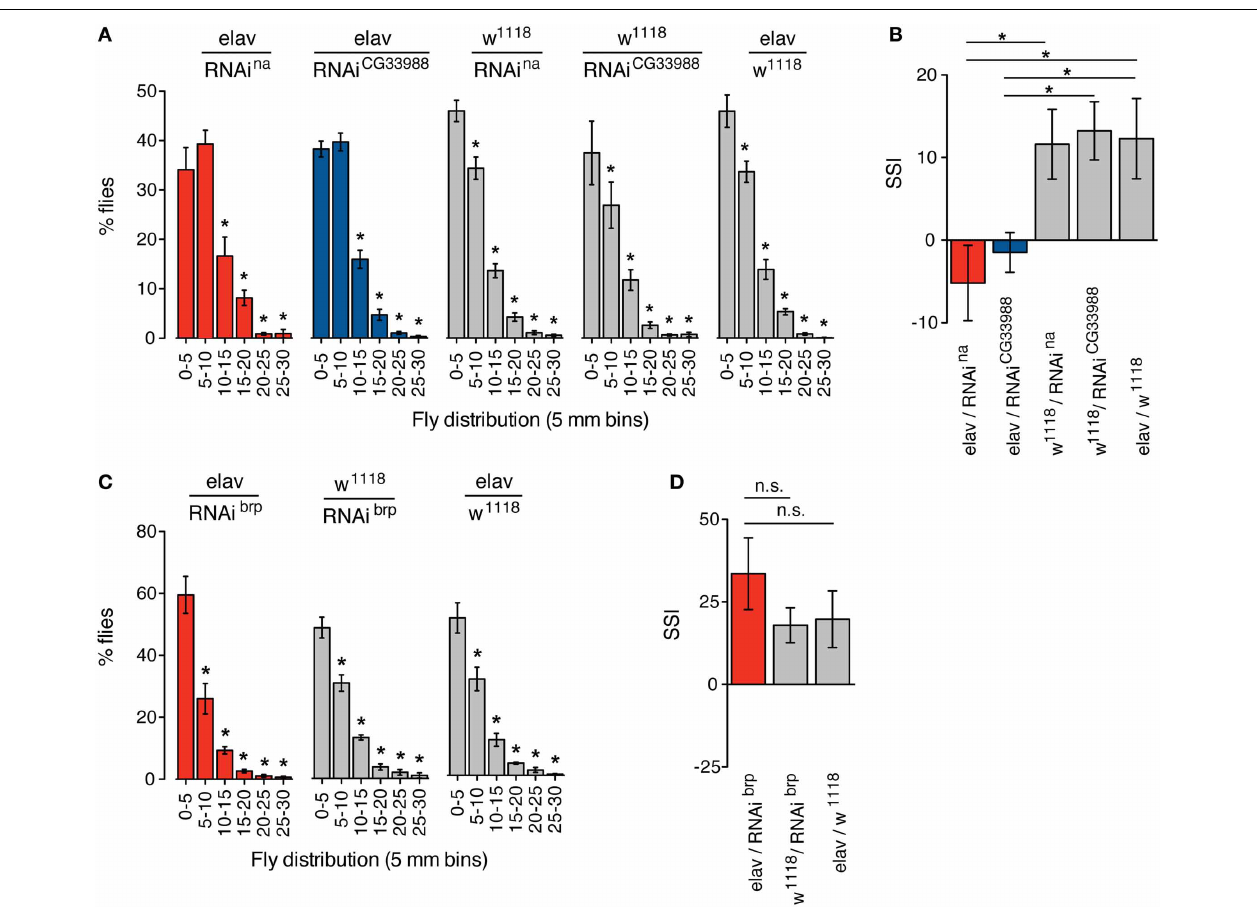
Index (SSI) calculated for the same groups of flies. (C) The histograms display the frequency distribution of the distance between each fly and their closest neighbor expressed as a percentage of the total population, in 5mm bins, for flies carrying a UAS-responsive RNAi against brp driven by the pan-neural elav -Gal4 driver and the respective control flies. (D) Social Space Index (SSI) calculated for the brp RNAi knockdown flies and the respective control flies. Error bars indicate s.e.m. ( n = 8 trials, 40 males per chamber). Asterisks denote statistically significant differences ( P < 0 . 05) based on One-Way Repeated Measures ANOVA with Dunnett’s post-hoc test for multiple comparisons to the control